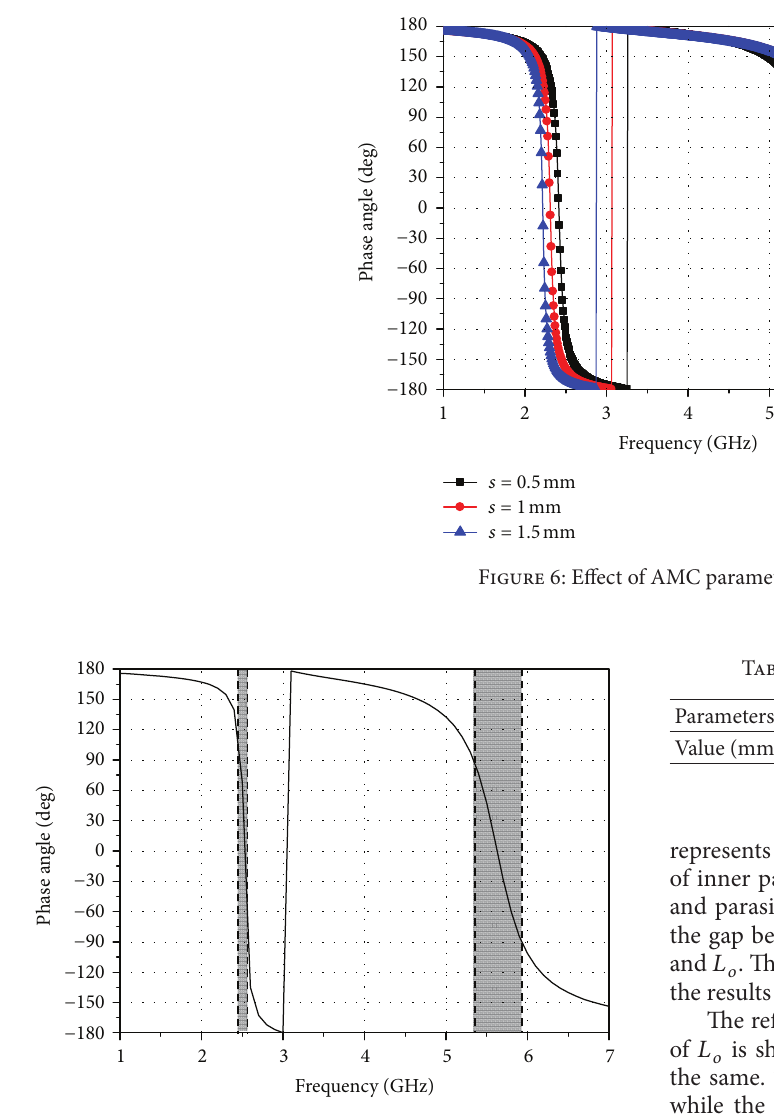
Figure 7: Reflection phase response for the uniplanar compact AMC structure.